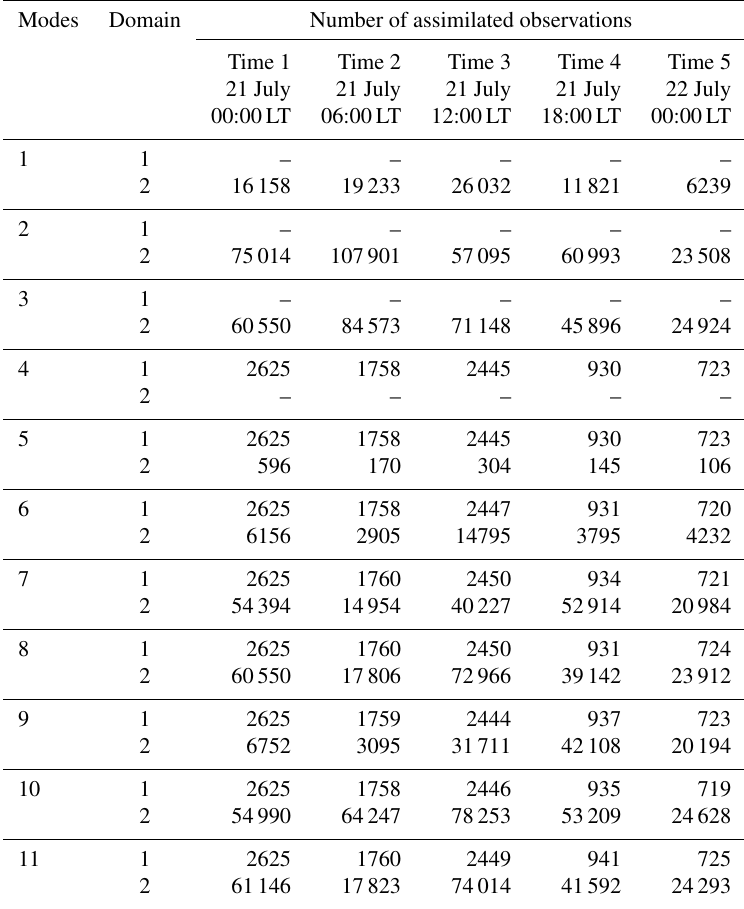
Table 5. Total number of assimilated observations in the two WRF nested